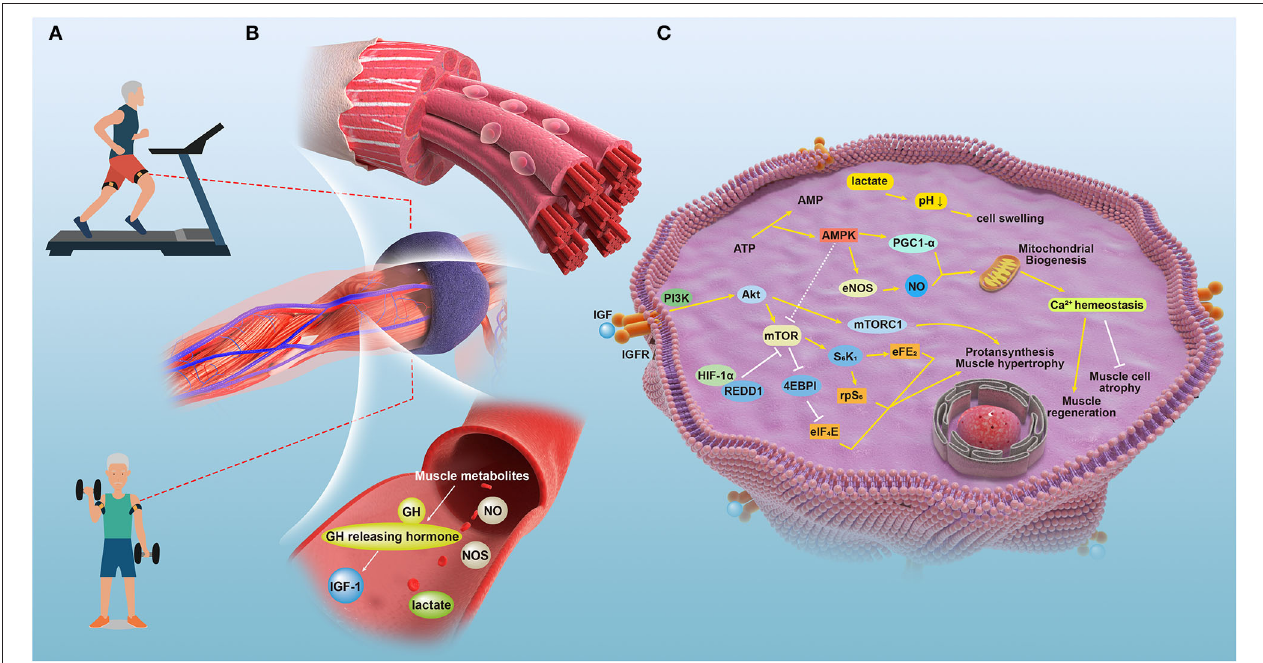
FIGURE 1 | The signaling mechanisms and the underlying crosstalk during BFRT sessions in relative tissues of patients with sarcopenia. (A) A depiction of the therapy applying blood flow restriction (BFR) to patient bodies during training sessions. (B) Effects induced by the temporal blockage that the local and partial muscles and vasculature underwent when applied with the external pressure of blood flow restriction bands. (C) The detailed molecular mechanisms underlying the improvement of physical performance led by BFRT in managing